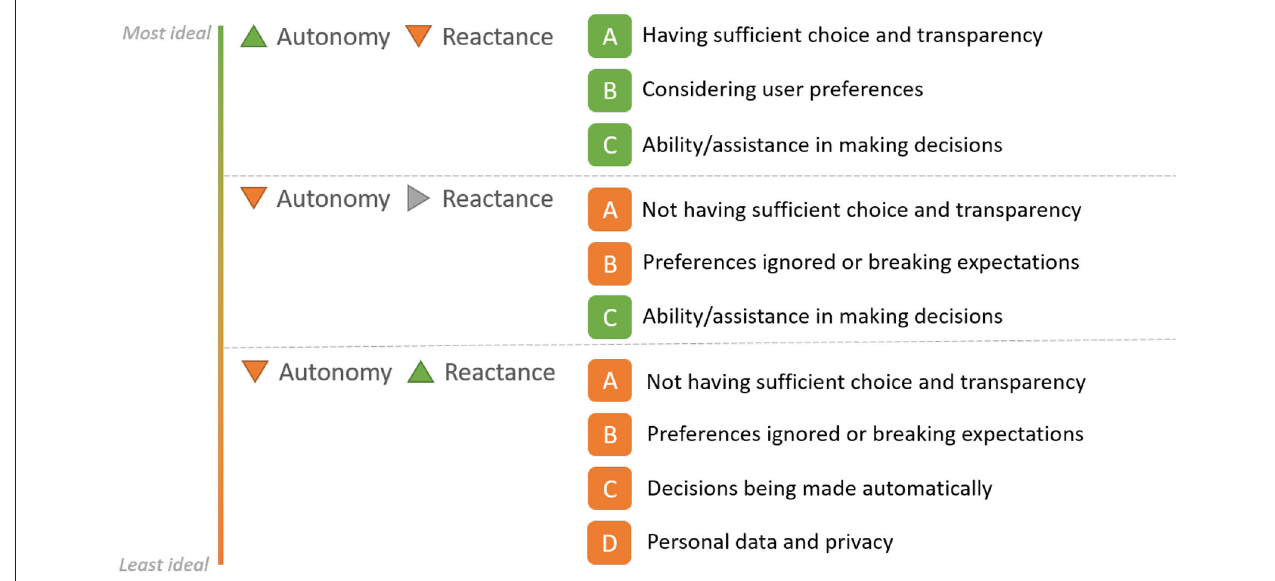
FIGURE 6 | Summary of inferences drawn from the study on different factors that influence the perception of autonomy and reactance.